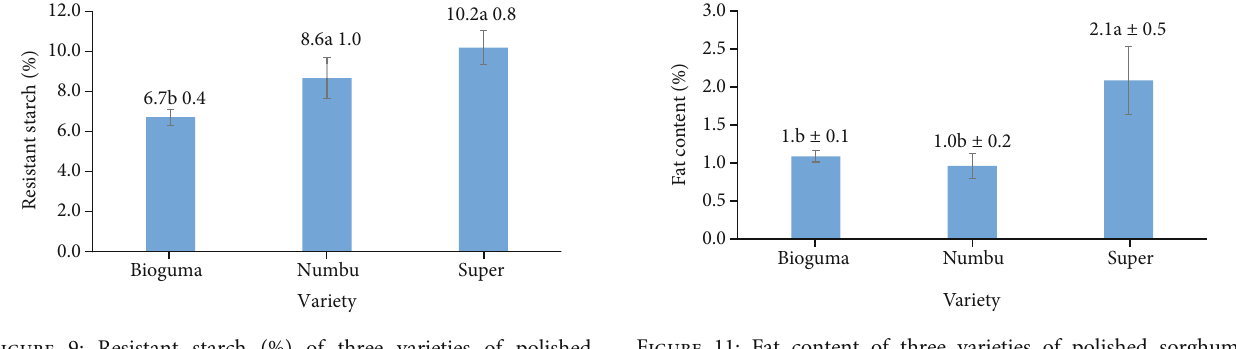
Figure 9: Resistant starch (%) of three varieties of polished sorghum grains.